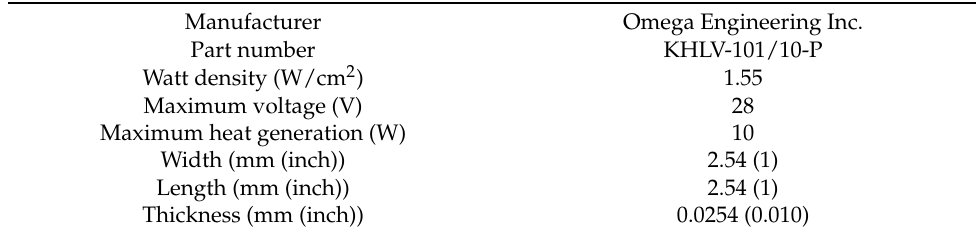
Table 1. Specifications of the polyimide film heater.